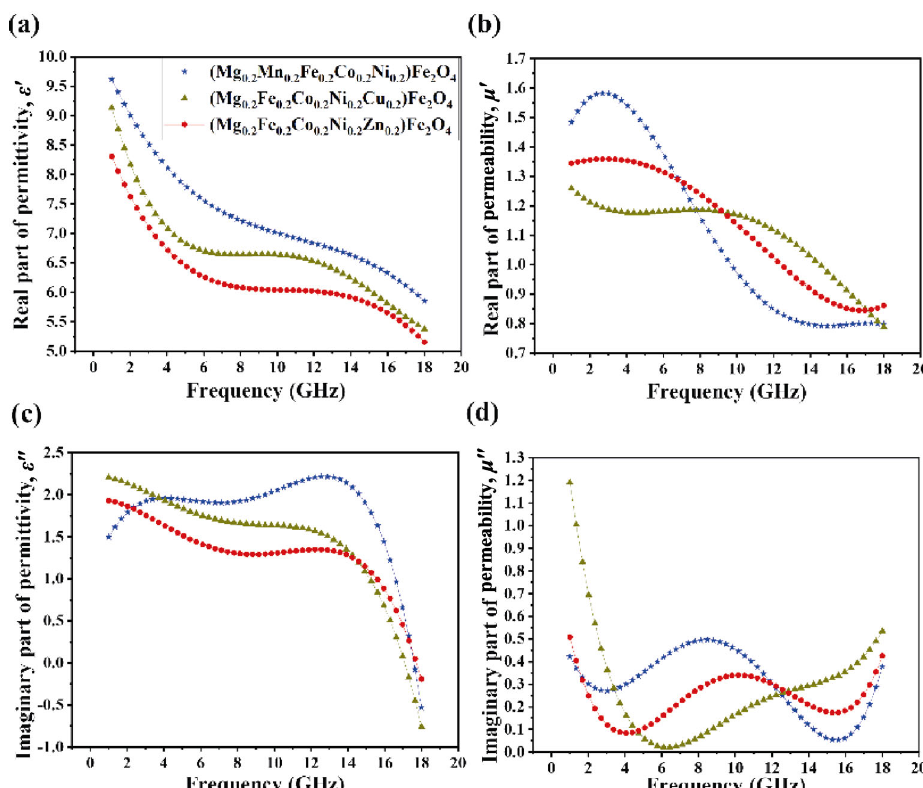
Fig. 7 EM parameters of HE MFe 2 O 4 : (a) real part of permittivity ( ε′ ), (b) real part of permeability ( μ′ ), (c) imaginary part of permittivity ( ε″ ), and (d) imaginary part of permeability ( μ″ ).